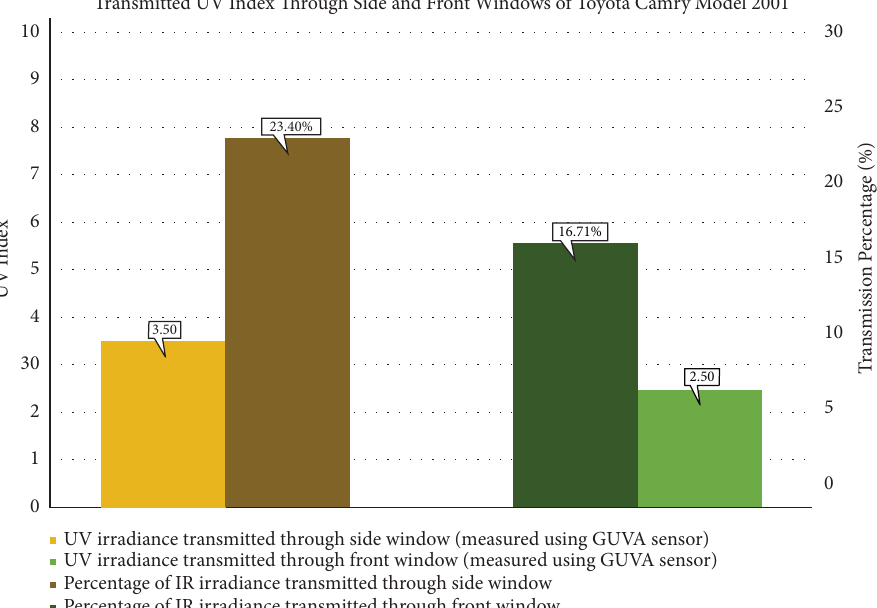
Figure 15: Transmitted UV index through the side (represented in green color) and front (represented in blue color) windows in a Toyota Camry model 2001